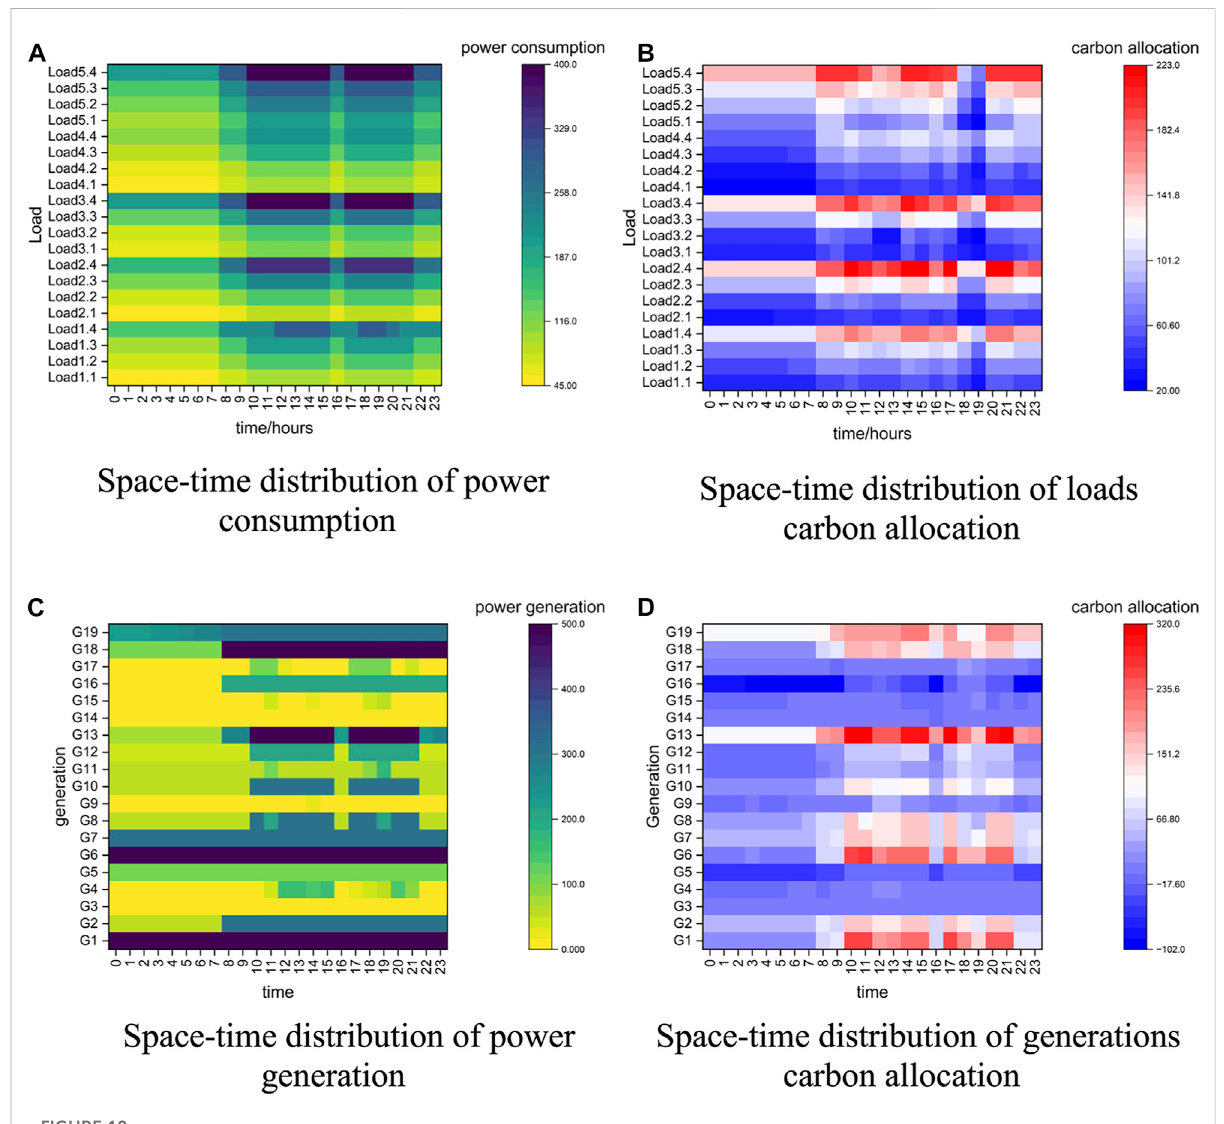
FIGURE 10 Consumption or generation of entity and carbon allocation result comparison. (A) Space-time distribution of power consumption. (B) Space- time distribution of load carbon allocation. (C) Space-time distribution of power generation. (D) Space-time distribution of generation carbon